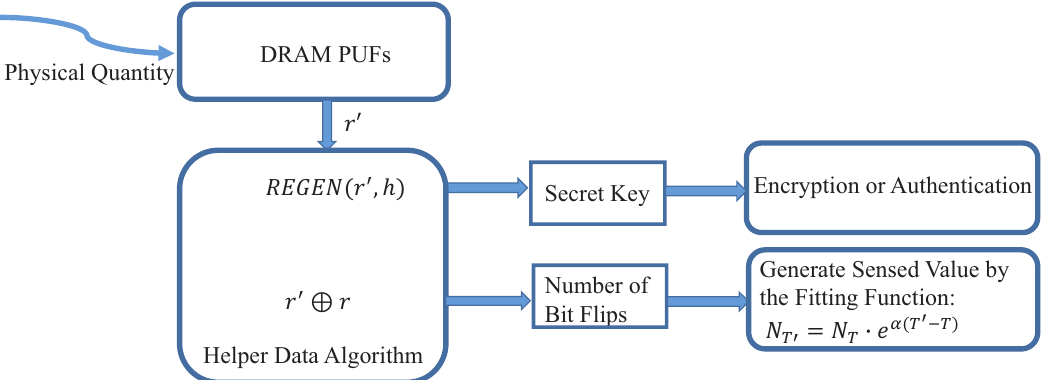
Figure 5. Module of DRAM PUF-based sensor fused with the key generation